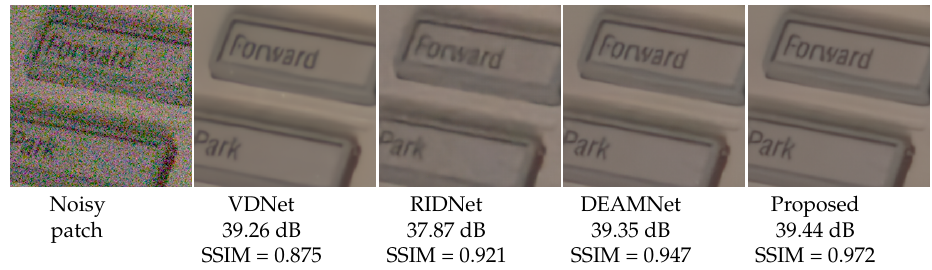
Figure 11. Visual quality comparison with PSNR and SSIM scores for the SIDD dataset with real noises (for best view, zooming in is recommended).